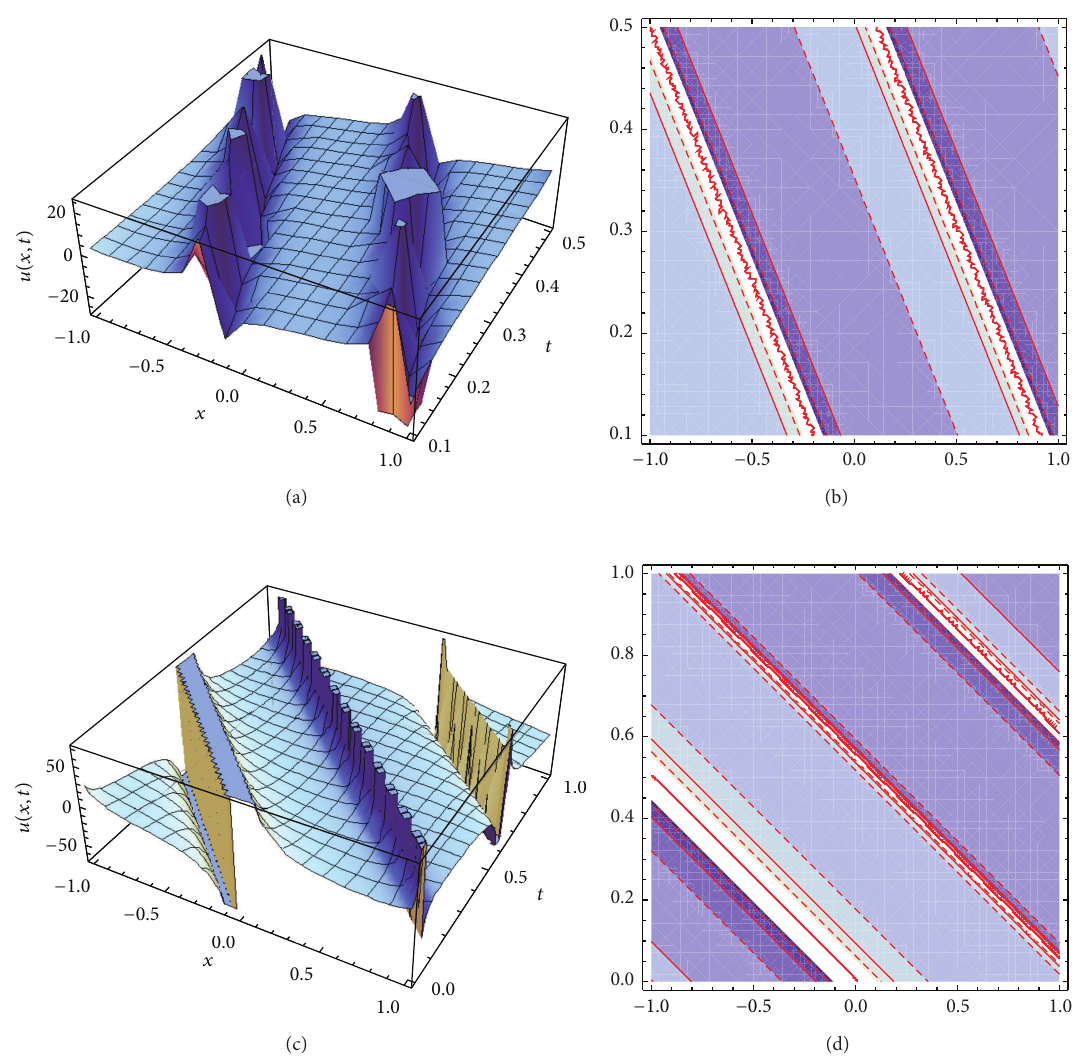
Figure 1: Travelling waves solutions (15) with various different shapes are plotted: periodic solitary waves in (a) and contour plot in (b). Travelling waves solutions (16) with various different shapes are plotted: periodic solitary waves in (c) and contour plot in